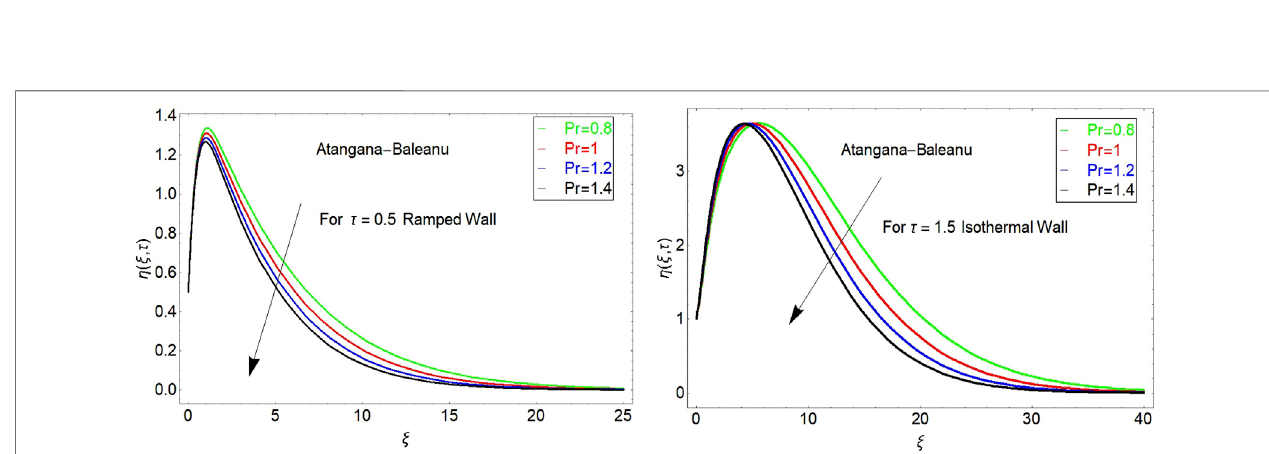
FIGURE 3 | In fl uence of Pr on velocity for constant and ramped temperature.